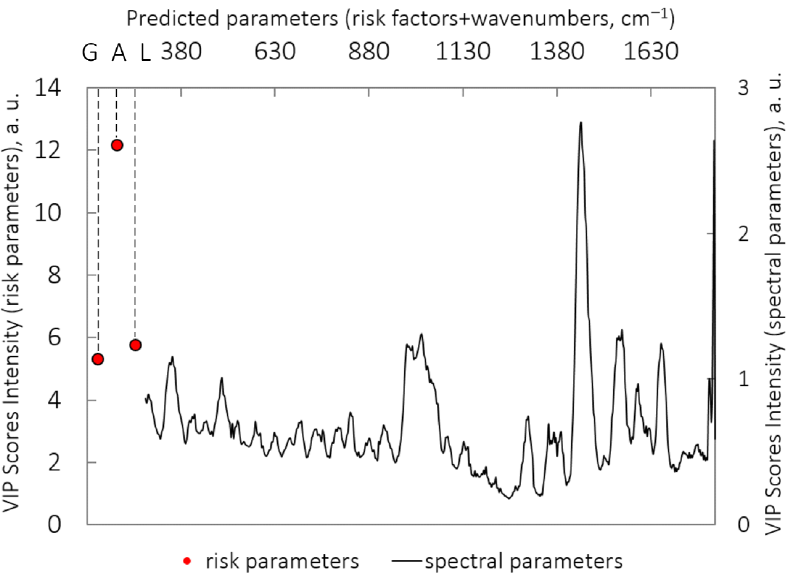
Figure 1. VIP scores for PLS-DA model: classification of malignant (n = 204) vs. benign (n = 413) neoplasms (I.1); importance values of risk factors and spectral factors are plotted along different horizontal axes because of a wide value scatter. (G) gender; (A) age; (L) localization.